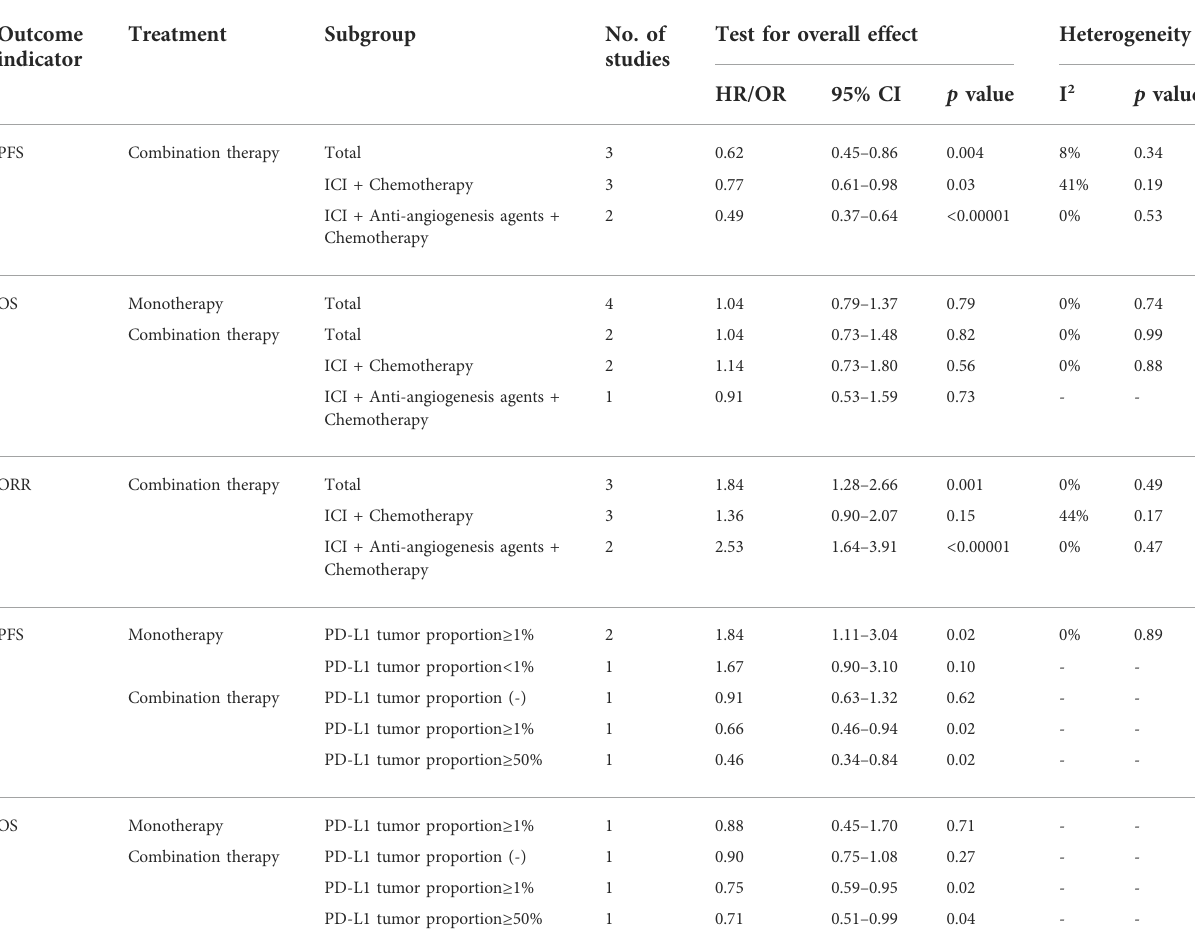
TABLE 3 Subgroup analysis. Outcome